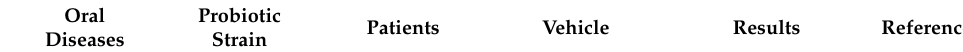
Table 3. Effects of probiotics in the oral